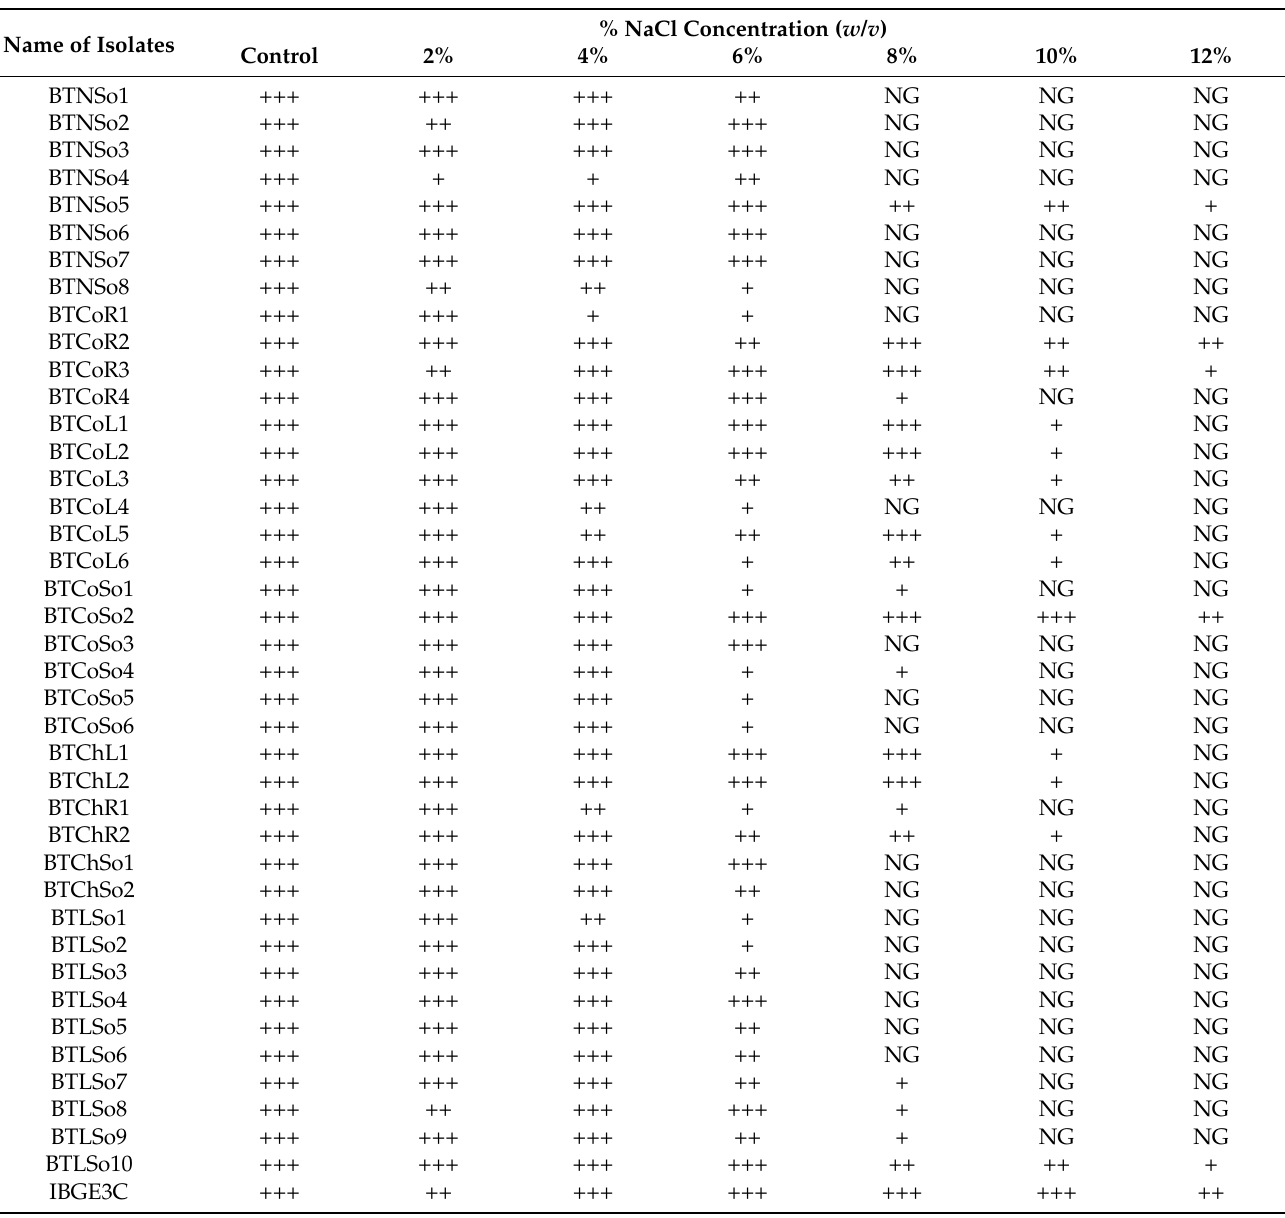
Table 1. Growth of isolated bacteria from different districts in the NBA medium containing varying concentrations of NaCl ( w / v